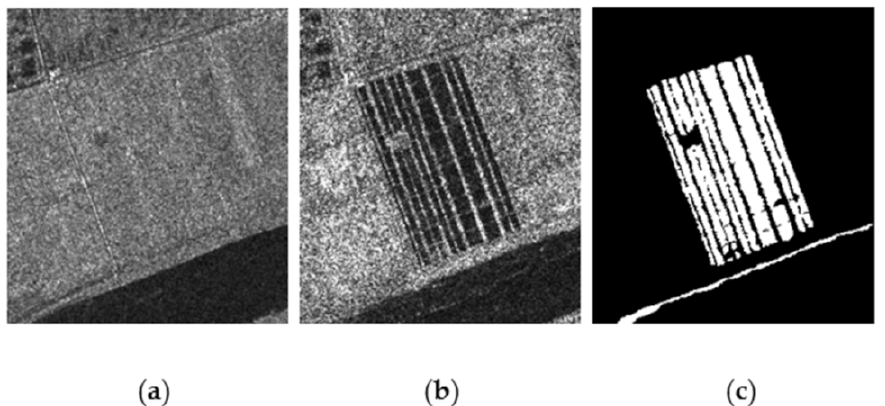
Figure 12. Farmland D dataset with a 3-m resolution. ( a ) Image acquired in June 2008. ( b ) Image acquired in June 2009. ( c ) Ground truth.